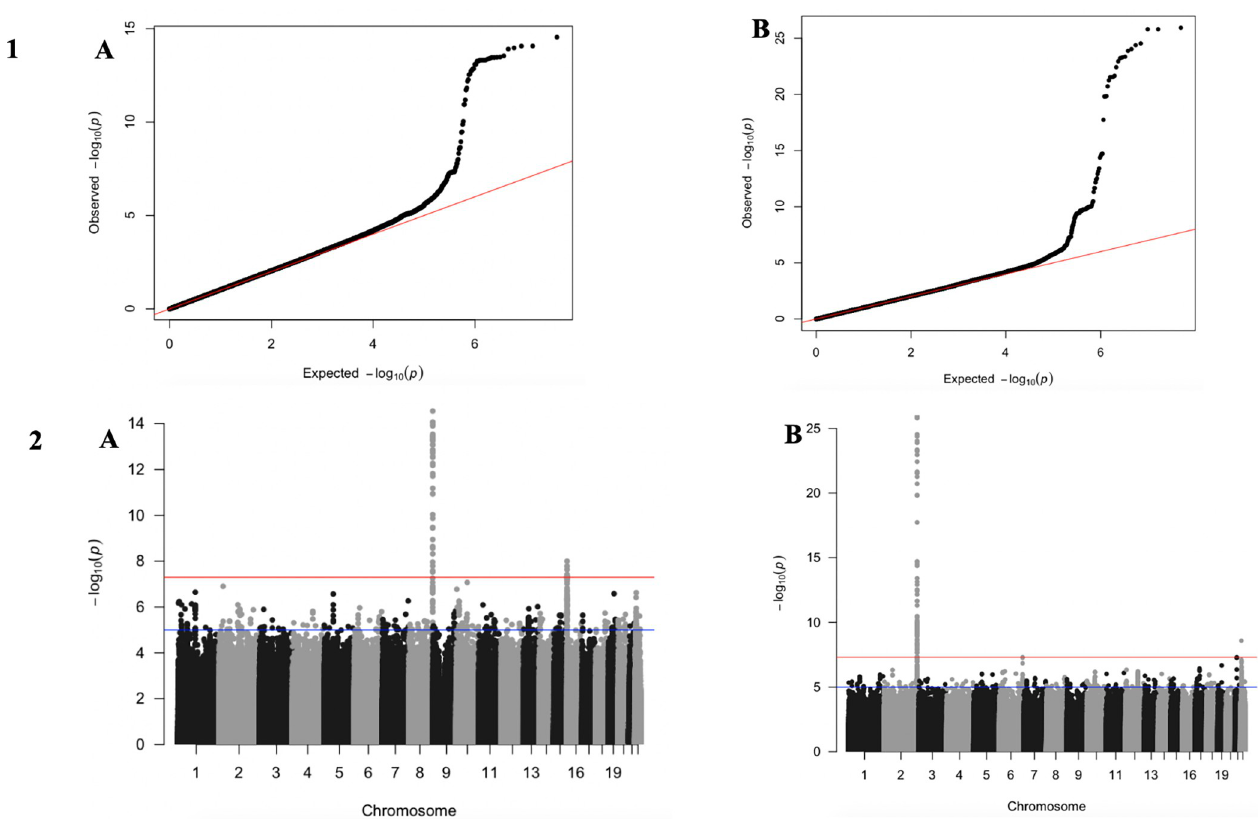
Fig 1. i - Quantile-quantile (QQ) plots of the UGRcohort (A) and the SZC cohort (B). The x-axis indicates the negative log-scale of expected p-values of each SNP, while the y-axis represents the negative log-scale of the observed p-values. The straight line indicates the expected results under Hardy-Weinberg equilibrium. The genomic inflation factors for the UGR and SZC cohort were 1.017 and 1.043, respectively ii: Manhattan plots showing SNPs associated with liver biomarkers in the UGR cohort (A) and the SZC cohort (B). In the UGR set of the GWAS, 59 SNPs were significantly associated with the correlated liver biomarkers. We performed a validation test by checking how many of the significant SNPs were replicated in the SZC at a threshold of P < 5x10 -2 , 13 remained significant after this test. Table in S1 File for SZC. In the mvLMM of SZC, 107 SNPs in chromosome 2 and 22 were signifi- cantly associated with the liver biomarker levels (S2 Table in S1 File), however 105 of the SNPs are in linkage disequilibrium with each other and none of the remaining 2 SNPs were replicated in SZC. We further highlighted the previously reported univariate results (Gurdasani et al.) of these two SNPs (S7 Table in S1 File) The closest gene to the SNP at chromosome 22 (rs4148325) is UGT1A (S8 Table in S1 File), while the second SNP has no known gene associated with it. In the SZC, 17 SNPs were significant in the SZC, while all the SNPs fall within a signal on chromo- some 2, rs1976391 mapped to UGT1A was identified as the lead SNP within this region. Downstream in-silico functional analysis. In order to identify independent and lead SNP with each locus, we undertook a distance clumping of 1 MB (500kb upstream and 500kb downstream) of the lead SNPs using an in-house script, and only two out of the 13 SNPs were left—rs374279268 (4.79 x10 -9 ) and rs148110594 (2.34 x10 -8 ). This implies that all the other eleven SNPs are in LD with chr 16 lead SNP (Fig 1). The nearest genes to the lead loci were Rhophilin Rho GTPase Binding Protein 1 (RHPN1) and Regulator of G Protein Signaling 11 (RGS11) , respectively (Table 2; S4 Table in S1 File). S6 Table in S1 File shows the univariate result of the two replicated SNPs.